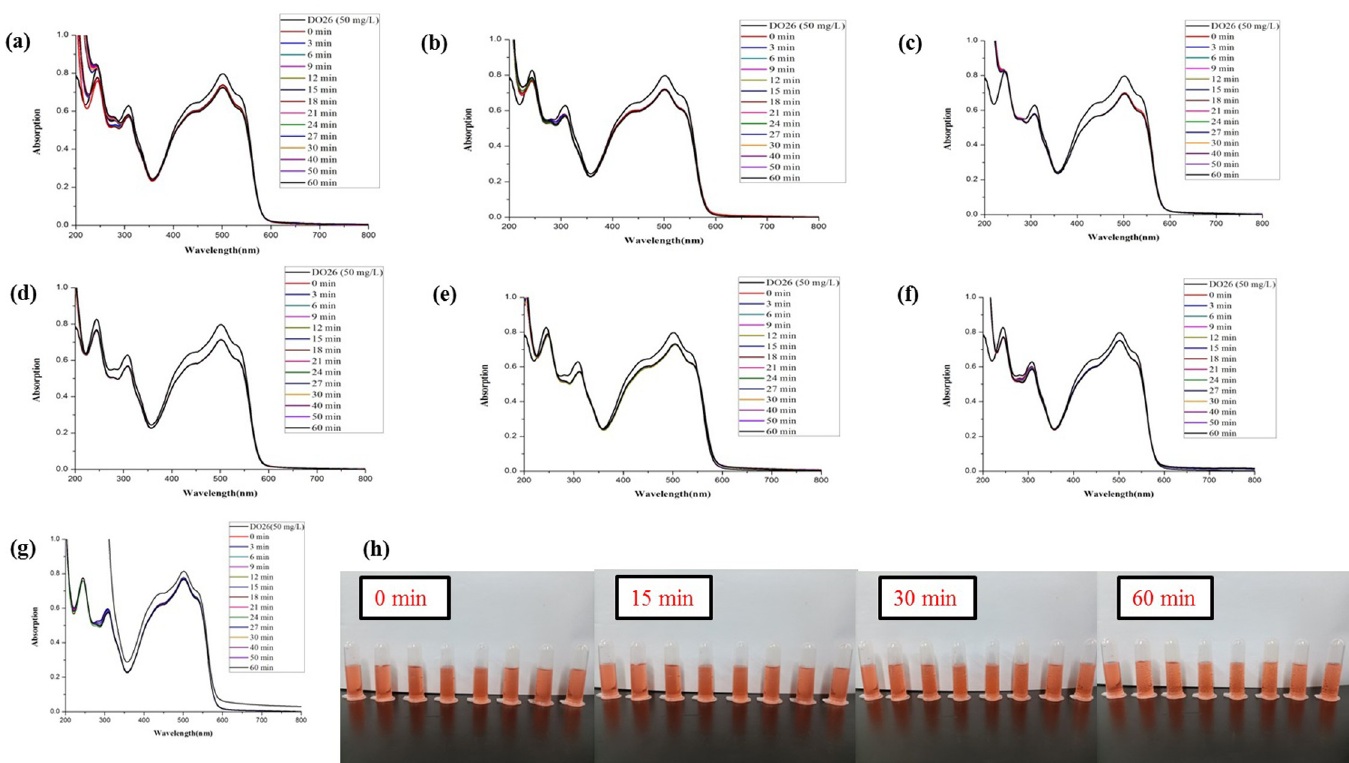
Fig 12. Comparison of the reductive degradation of Direct Orange 26 using different dry ginger extracts: (a) unpeeled dry ginger water extract; (b) peeled dry ginger water extract; (c) ginger dry peel water extract; (d) unpeeled dry ginger ethanol extract; (e) peeled dry ginger ethanol extract; (f) dry ginger peel ethanol extract; (g) CK; (h) The solution appearance comparison of mixtures different dry ginger extract and DO26 after reaction for 0, 15, 30 and 60 min. The solutions from left to right are DO26 (50 mg/L), CK, unpeeled dry ginger water extract, peeled dry ginger water extract, dry ginger peel water extract, unpeeled dry ginger ethanol extract, peeled dry ginger ethanol extract, and dry ginger peel ethanol